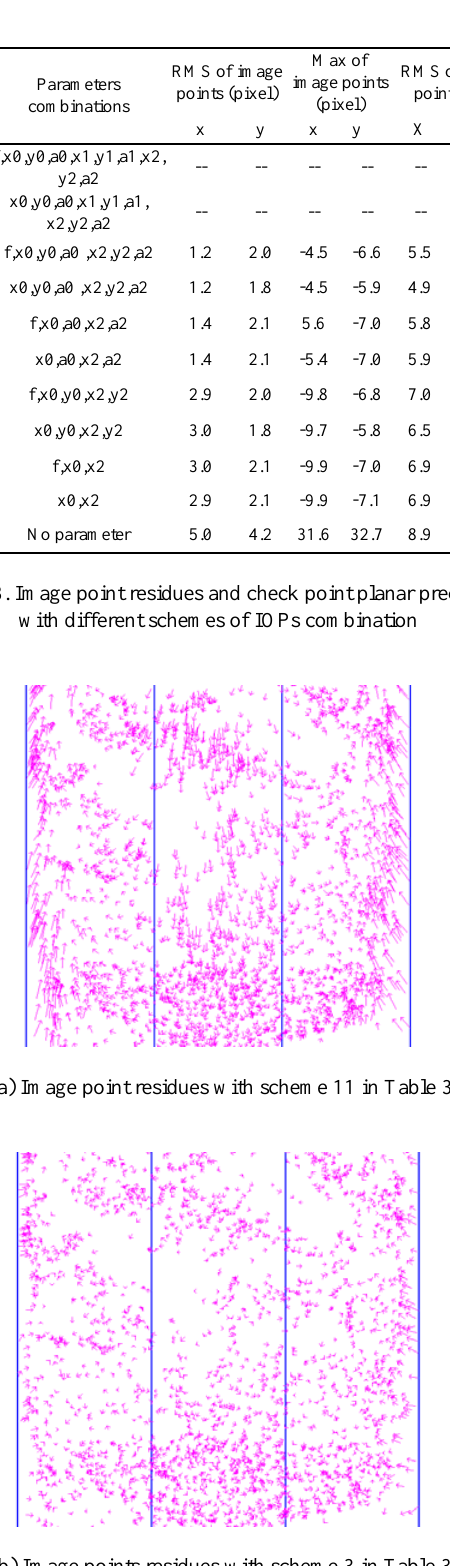
(b) Image points residues with scheme 3 in Table 3 Figure 6. Distribution of image point residues with different schemes